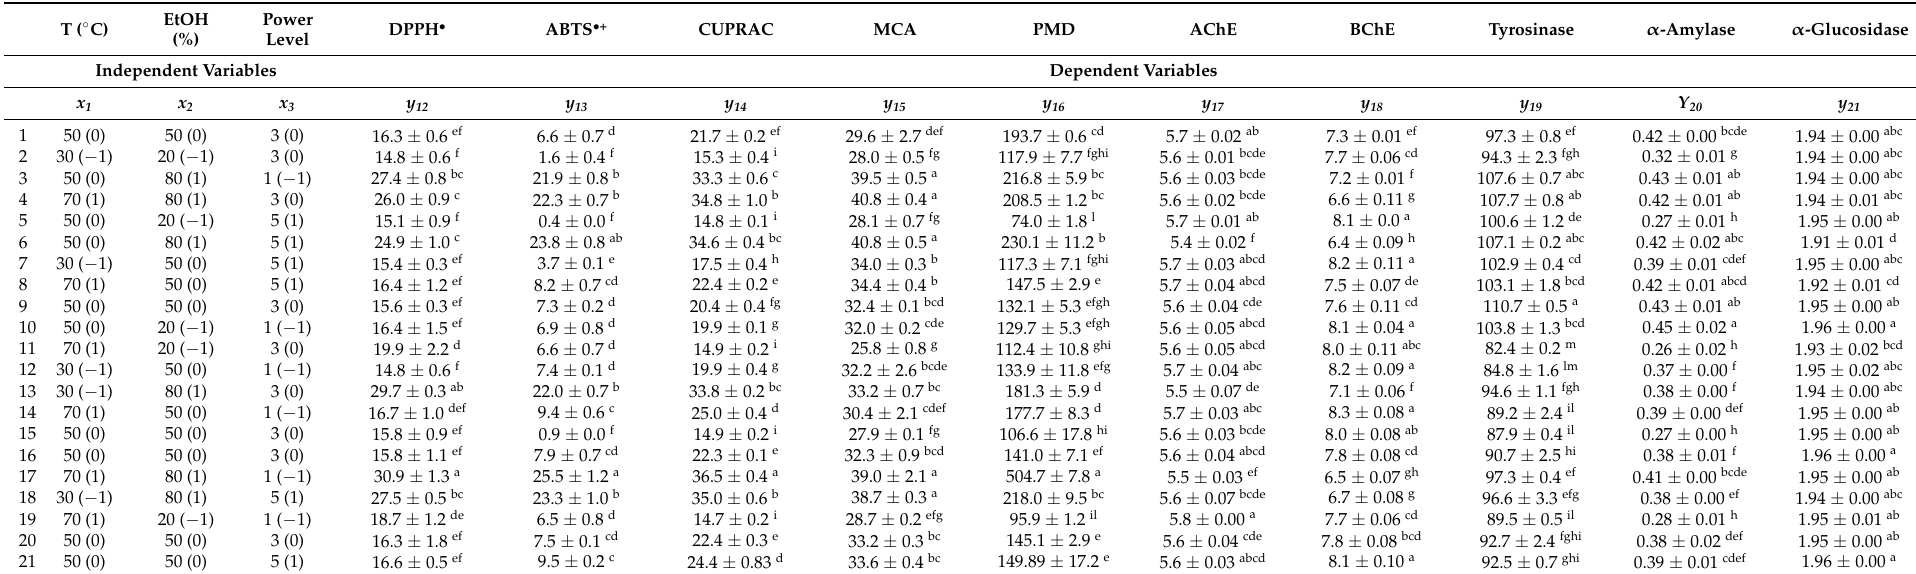
Table 2. Central composite design and experimental results obtained for dependent variables